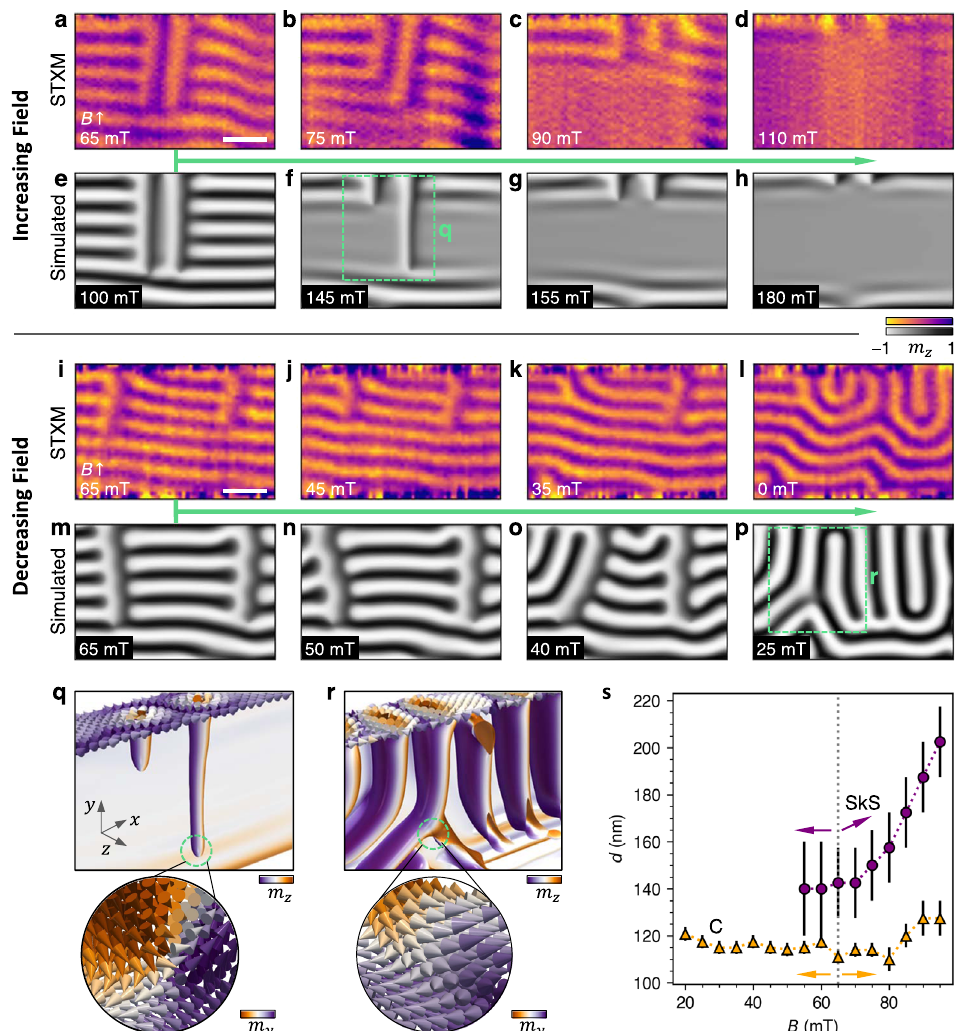
Fig. 3 Field stability of the skyrmion string spin texture in a nanowire geometry. a – p X-ray microscopy images ( a - d , i - l ) and simulated images ( e - h , m - p ) of the skyrmion string (SkS) spin texture as a function of increasing ( a - h ), and decreasing ( i - p ) in-plane (IP) applied magnetic fi eld, as indicated by the green arrows. The colourmap indicates the out-of-plane magnetisation component, m z . The scale bar is 250 nm. q , r Three dimensional visualisation of the simulations in f and p respectively, as indicated by the green boxes. The insets show a visualisation of the local spin structure at the end point of the SkS ( q ), and at the formation point of a dislocation ( r ), highlighting the diverging magnetisation indicating the presence of a Bloch point. The colourmap indicates the local magnetisation component, m x , y , z . s , The experimentally determined spacing d of the SkS (purple circles) and conical (C, orange triangles) states as a function of the applied fi eld. The dotted line and arrows show the initial point and direction of the fi eld sweep. Error bars indicate the error calculated due to the resolution limit, and the averaged number of measured SkS/C